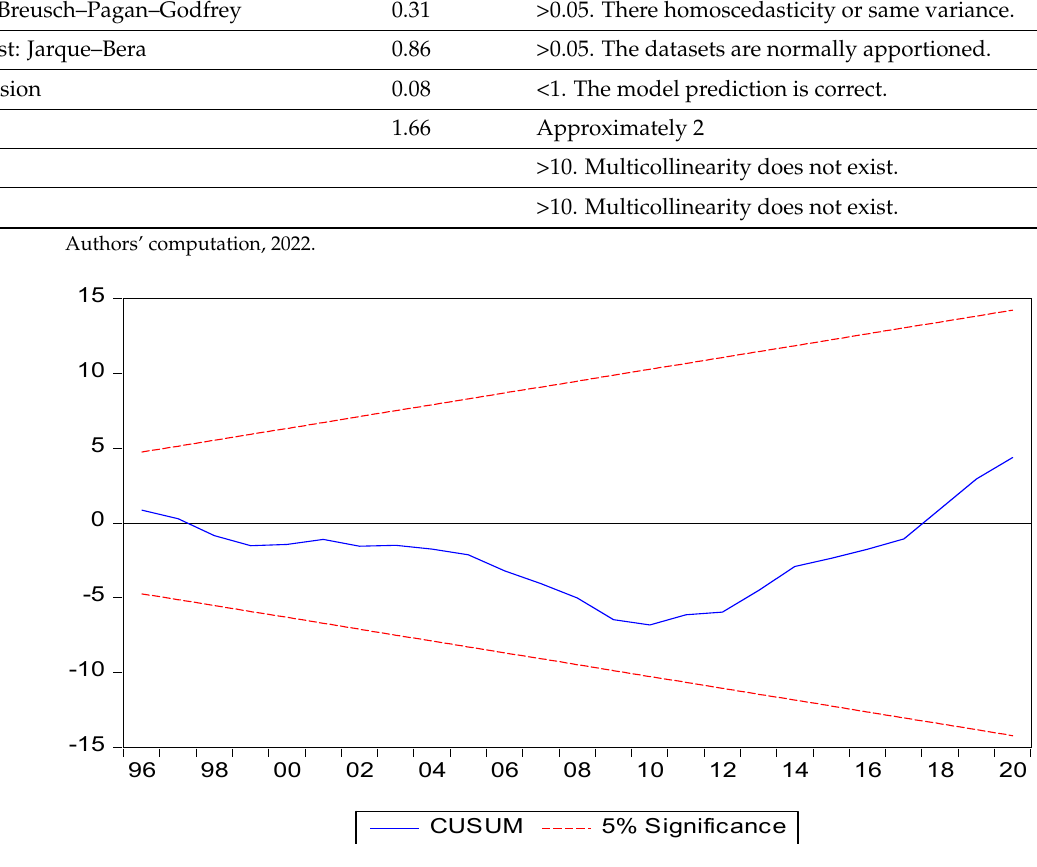
Figure 1. Stability test confirmation.